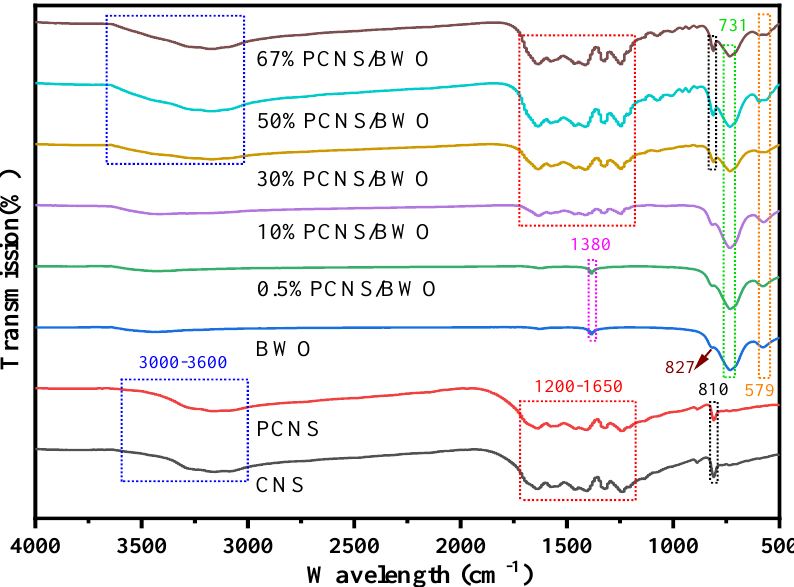
Figure 3. FTIR spectra of the synthesized samples.